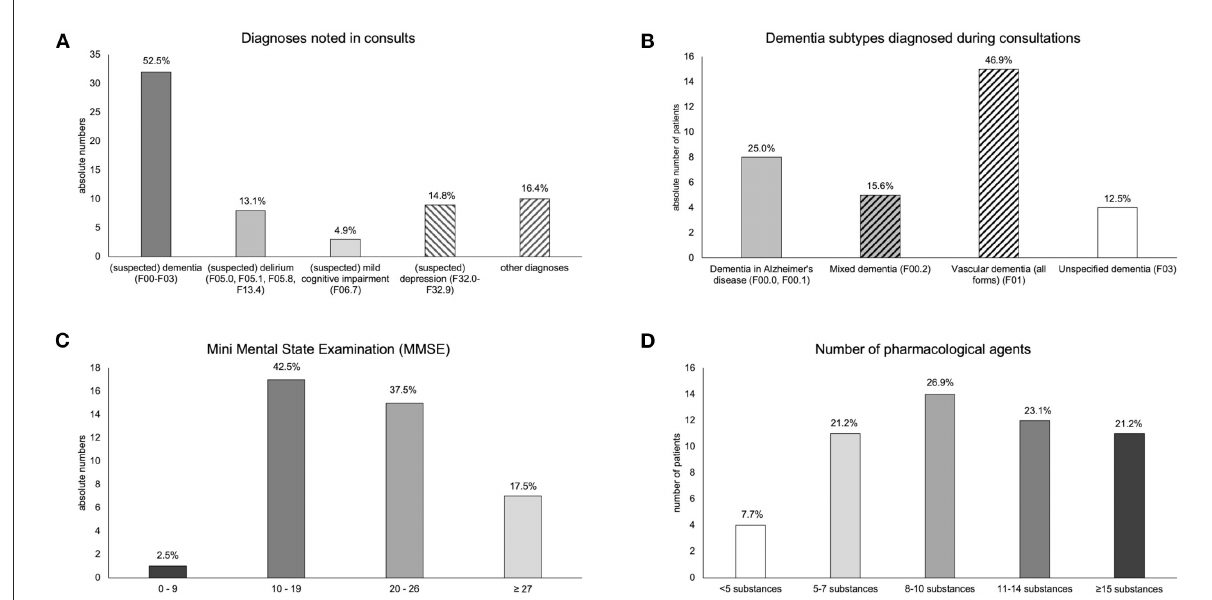
FIGURE4 Diagnostic assessment during consultations. (A) Primary diagnoses noted by the consulting physicians. (B) Proportions of dementia subtypes among patients diagnosed with any form of dementia. Medium gray denotes the (suspected) presence of Alzheimer’s pathology. Hatch fill denotes (suspected) vascular pathology. (C) MMSE scores among the patients investigated during consultations. (D) Number of pharmacological agents taken by the